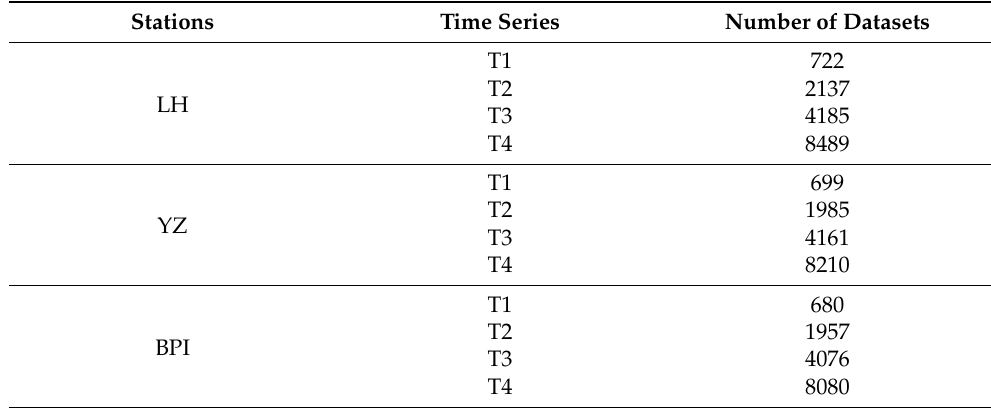
Table 2. Data information with complete values at different stations in different time